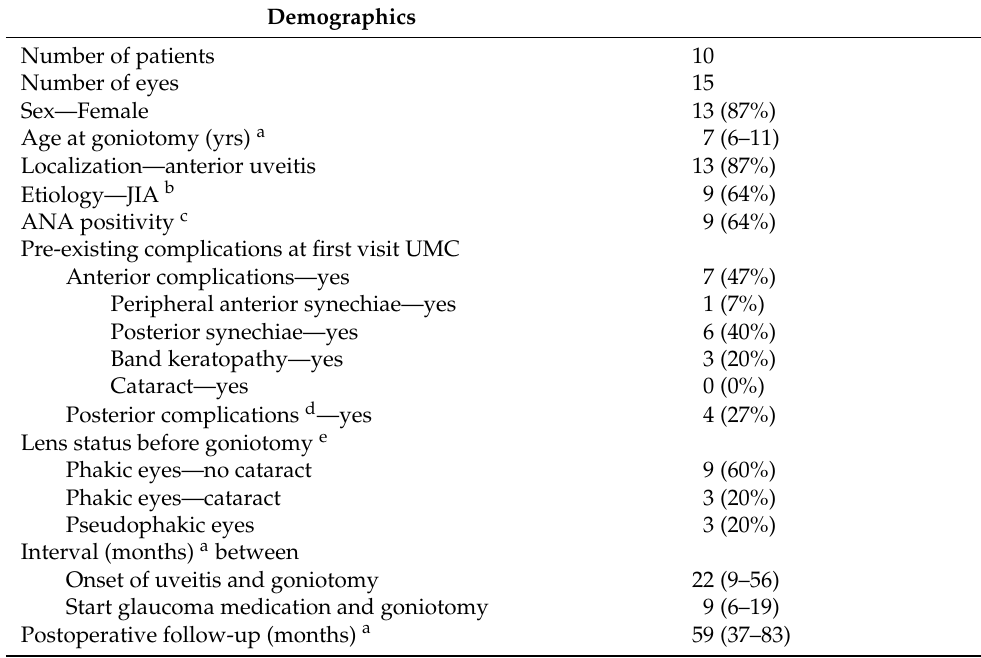
Table 1. Demographics per